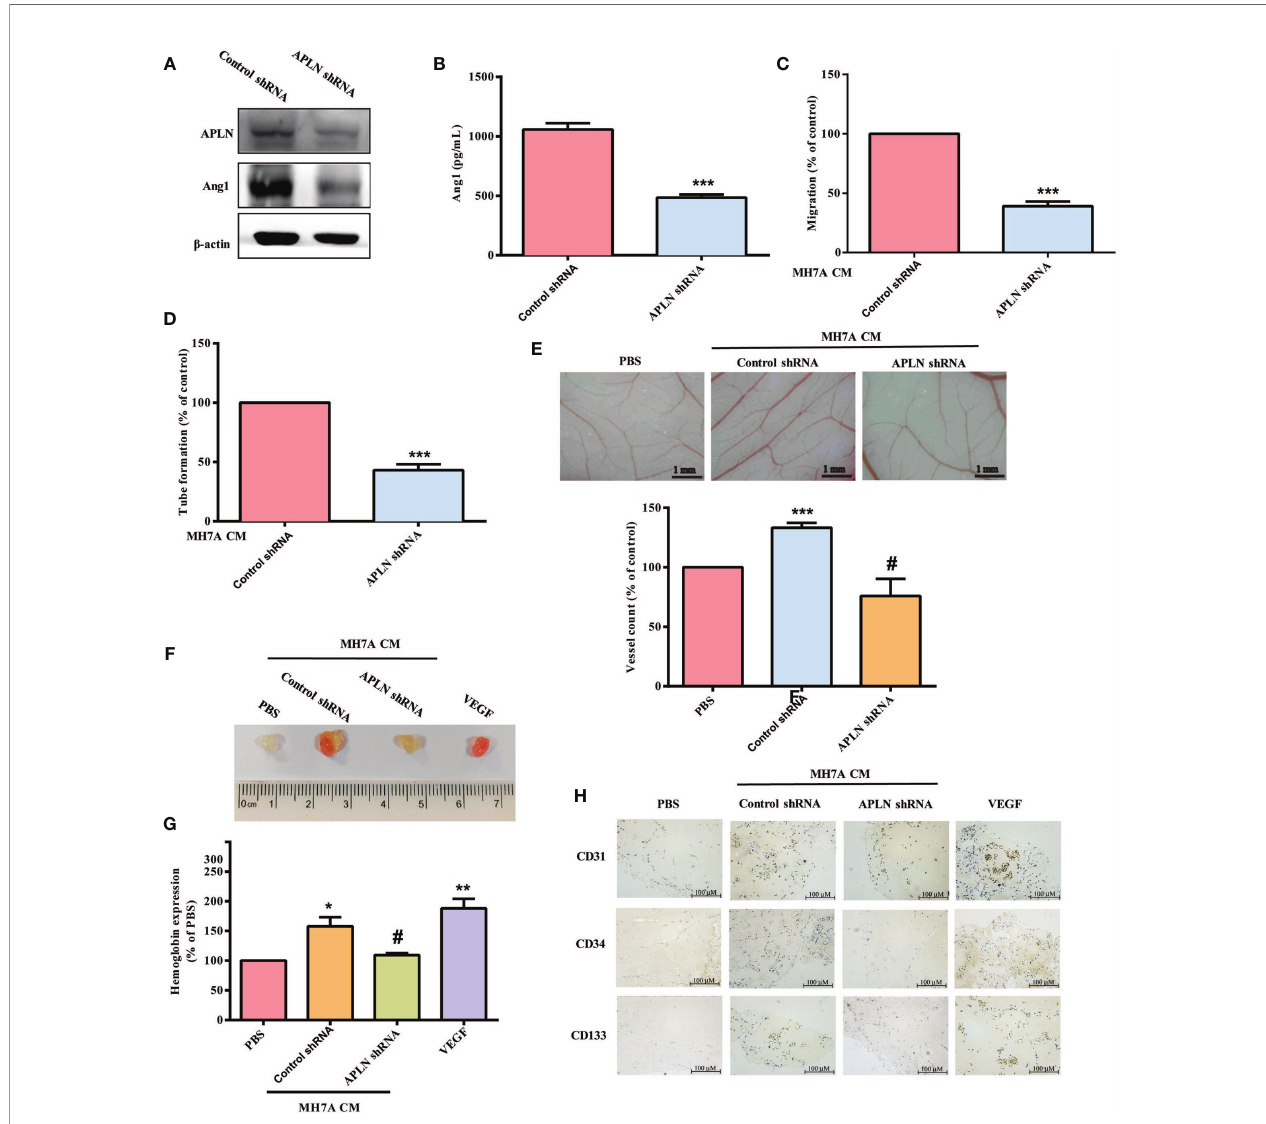
FIGURE 5 | Inhibition of APLN reduces EPC angiogenesis in vivo . (A, B) RASFs were infected with APLN shRNA for 24 h. APLN and Ang1 expression was examined by Western blot (n=3) and ELISA. (C, D) Collected CM was applied to EPCs, and EPC angiogenesis was quanti fi ed. (E) After subjecting RASFs to the treatment conditions as indicated, the harvested CM was applied to 6-day-old fertilized chick embryos for 4 days. CAMs were examined by microscopy and photographed, and vessels were counted manually. (F, G) Matrigel plugs containing the harvested CM were subcutaneously injected into the fl anks of nude mice. After 7 days, the plugs were photographed, and hemoglobin levels were quanti fi ed. (H) Plug specimens were immunostained with CD31, CD34 and CD133 antibodies. * p < 0.05, ** p < 0.01 and *** p < 0.001 versus the control group; # p < 0.05 versus the APLN-treated